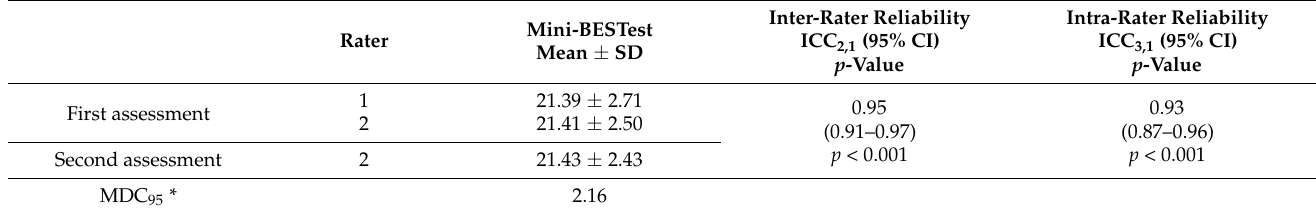
Table 3. Mean ± SD and intra and inter-rater reliability of Mini-BESTest from n = 44.